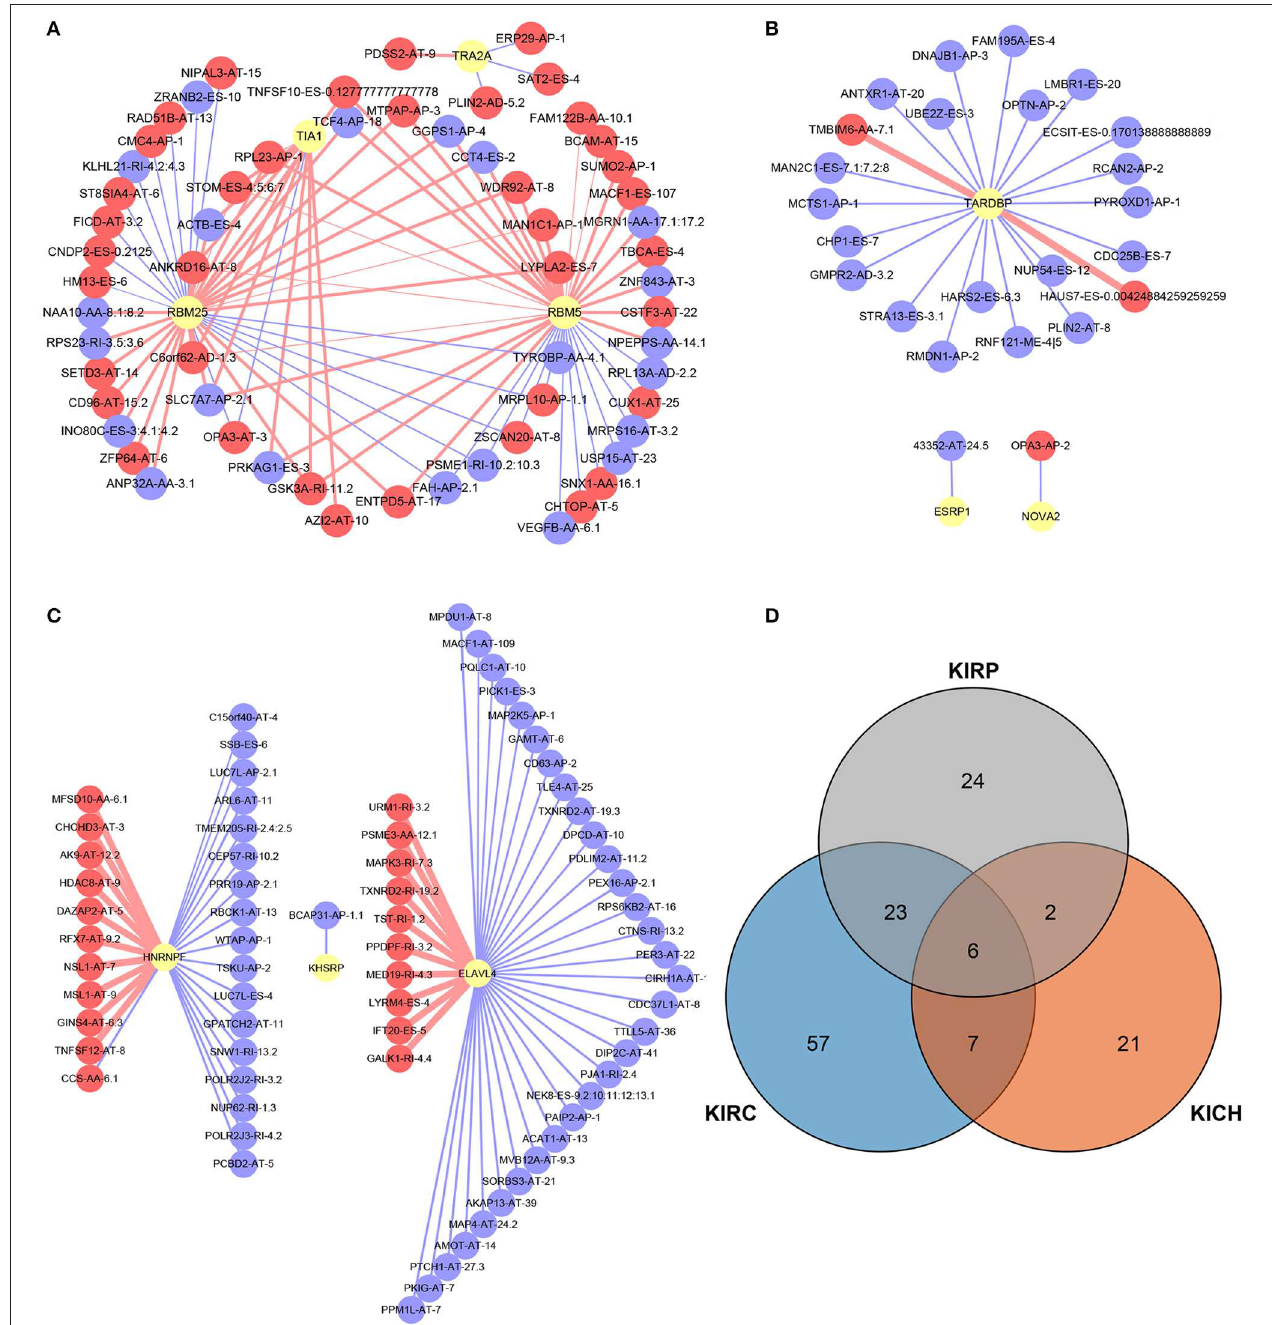
FIGURE 6 | SF-AS events regulatory network and the distribution of the key genes in PPI network. (A–C) The SF-AS events regulatory networks in KIRC, KICH, and KIRP, respectively. The red nodes represented the AS events that were positively related to survival. The purple nodes represented the AS events that were negatively related to survival. The red and purple lines represented a positive and negative correlation between the connected nodes, respectively. The larger the correlation coefficient was, the thicker the line was and vice versa. (D) The distribution of the key genes in PPI network. The orange, blue, and gray areas represent the genes in KIRC, KICH, and KIRP, respectively. The genes shown in overlapping regions exist in all relevant groups.